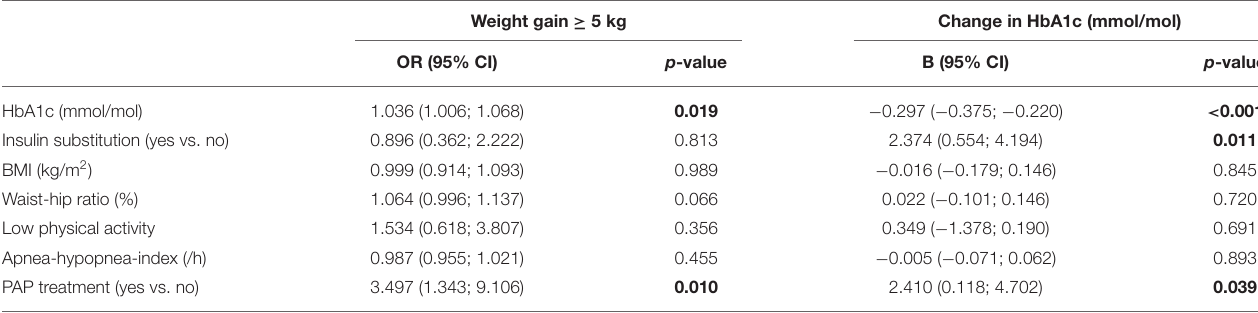
Shown are the unstandardized regression coefficients by regression analysis, 95% CI and p-values. BMI, body-mass index; HbA1c, hemoglobin A1c; PAP, positive airway pressure; SDB, sleep-disordered breathing; low physical activity = exercise < 3 × /wk. The bold values are p-values <